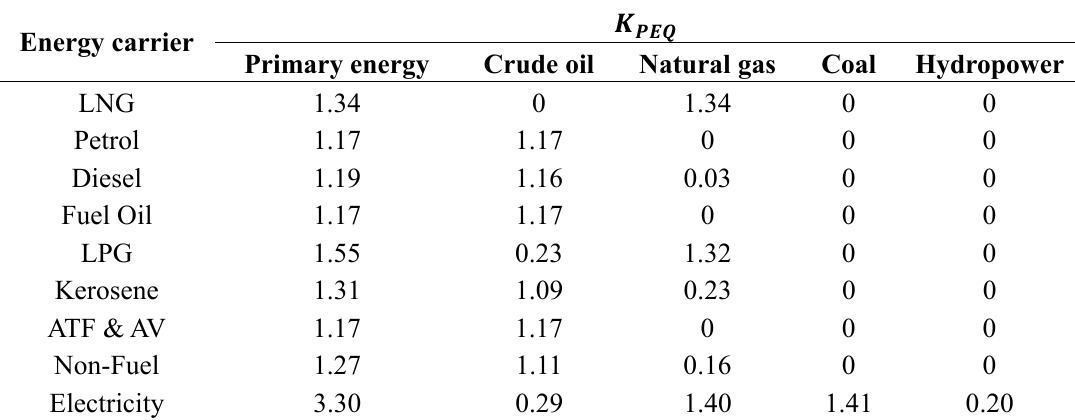
Table 4. The transformation factors used in the